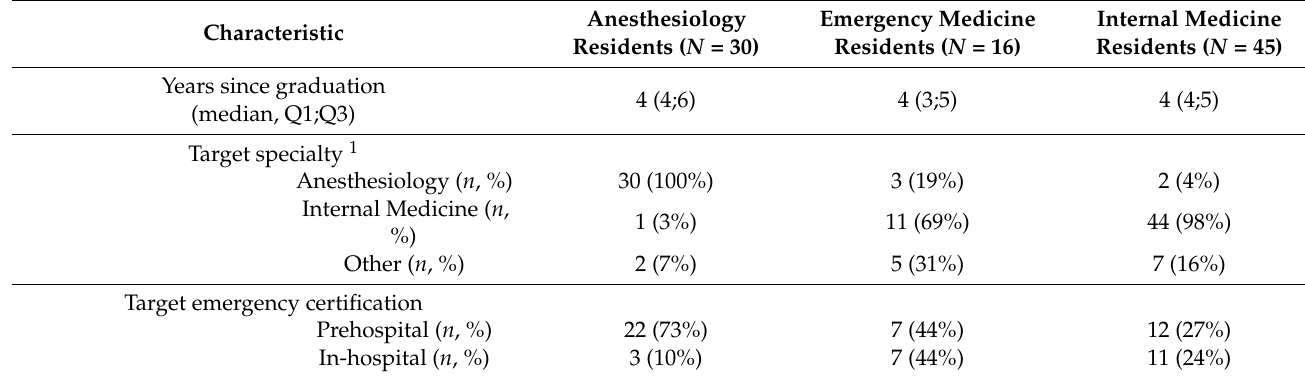
Figure 1. Experimental flowchart. Table 1. Characteristics of survey participants.